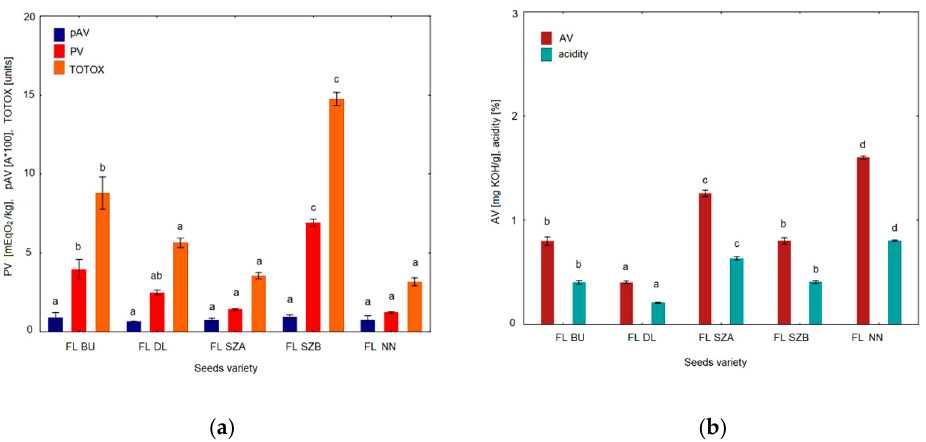
Figure 9. Oxidative stability parameters of five cold ‐ pressed flaxseed oils: ( a ) Peroxide value (PV), p ‐ anisidine value (pAV), total oxidation rate (TOTOX) value; ( b ) Acid value (AV), acidity. Different superscript letters (a, b, c, d) indicate significant differences ( p < 0.05). FL BU (Bukoz Flaxseed cultivar), FL DL (Dolguniec Flaxseed cultivar), FL SZA, FL SZB (Szafir Flaxseed cultivar), FL NN (Unknown Flaxseed cultivar).